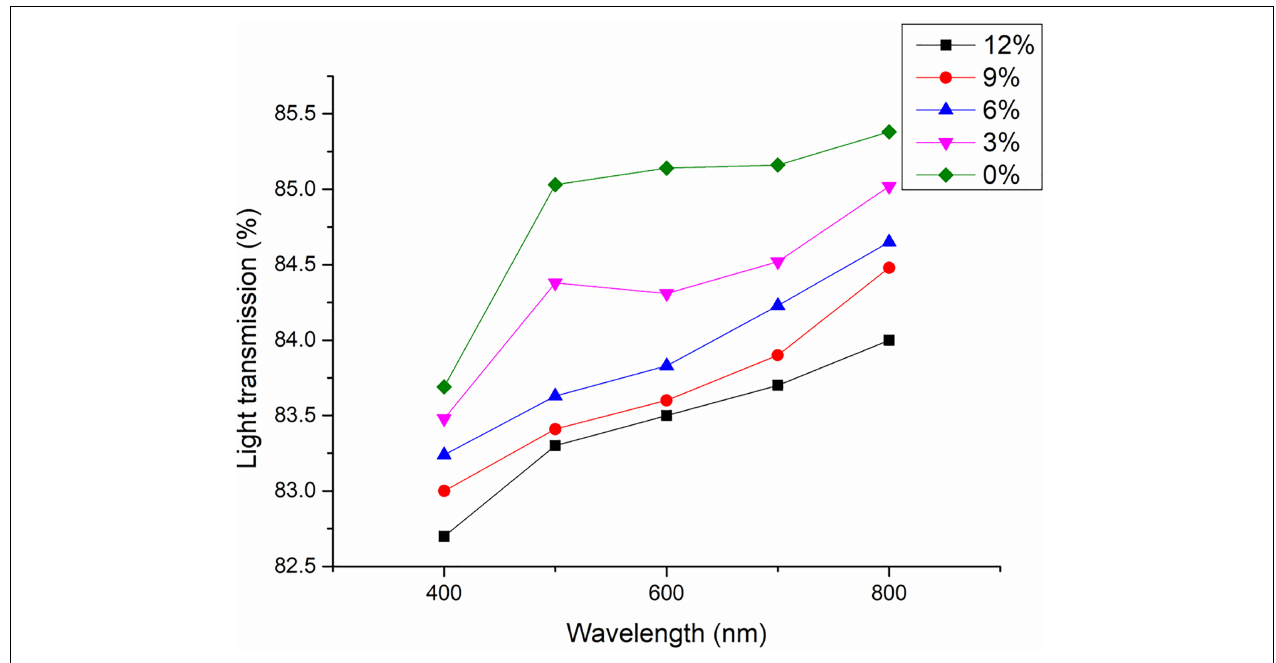
FIGURE 5 | The effect of the addition of ASCNC on the transparency of composite films. Amount of ASCNC: 0% ( (cid:7) ); 3% ( (cid:72) ); 6% ( (cid:78) ); 9% ( • ); 12% ( (cid:4) ).